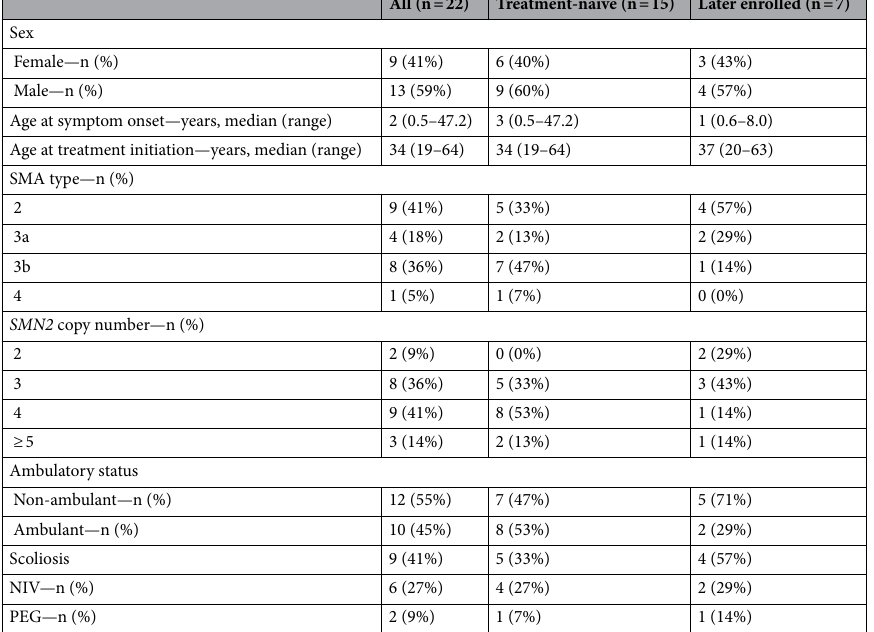
Table 1. Baseline demographics of enrolled patients, divided in patients who were enrolled treatment-naïve and during ongoing treatment. m module [median, range], n number, NIV non-invasive ventilation, PEG percutaneous endoscopic gastrostomy, SMA spinal muscular atrophy, SMN2 survival of motor neuron 2 (gene), y